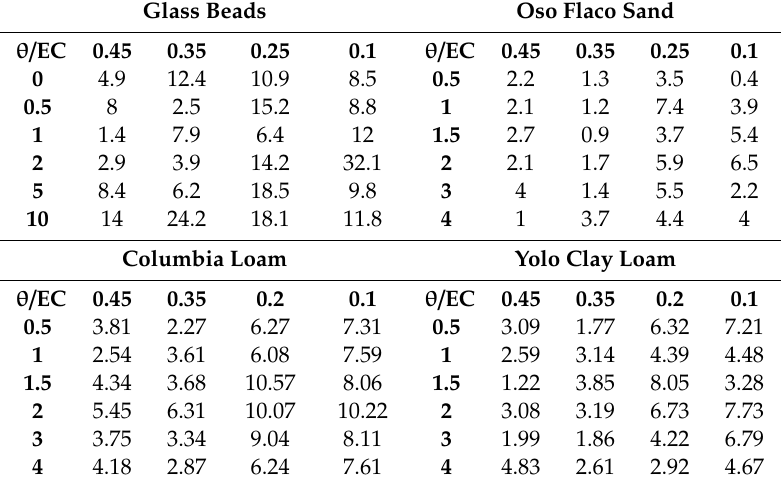
Table 2. Coe ffi cient of variation ( CV ) of sensor resistance with varying actual water contents with respect to di ff erent electrical conductivity solutions ( CV = σ / µ × 100%).